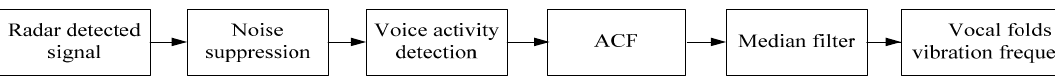
Figure 3. Block diagram of the signal-processing method.